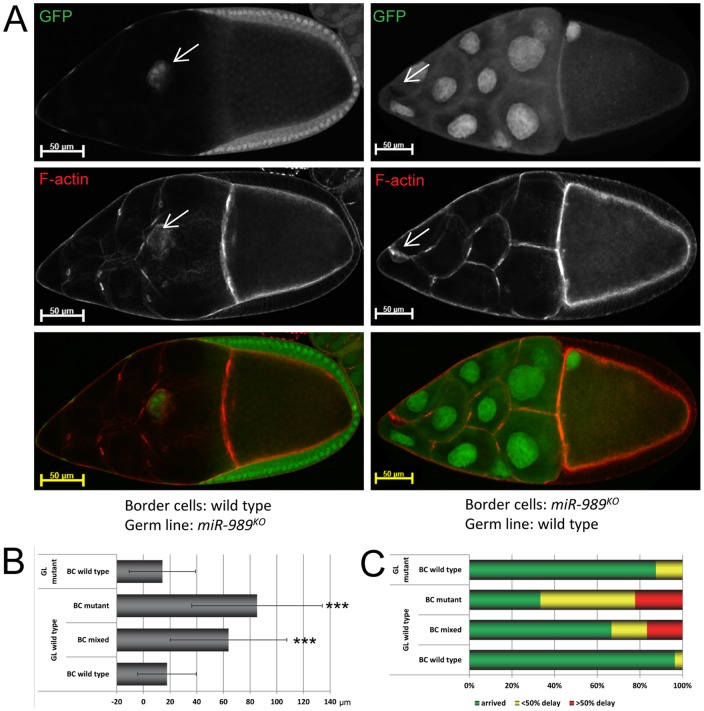
Clonal analysis demonstrates a somatic requirement for miR-989 for normal border cell migration.A Genetic mosaics: wild type cells are labelled by nuclear GFP (upper panel) while miR-989 mutant cells do not express GFP. The middle panels are labelled with phalloidin to highlight the F-actin cytoskeleton. The two egg chambers shown represent extreme cases of mosaicism. In the stage 10A egg chamber on the left all somatic cells are wild-type (GFP positive), while all germ line cells are mutant for miR-989 (GFP negative). The border cells were not delayed in their migration. In the stage 10A egg chamber shown on the right all germ line cells are wild type (GFP positive) while all somatic cells are mutant for miR-989 (GFP negative). Border cell migration was strongly delayed. B Quantification of the migration defects in migrating border cells in late stage 9 and stage 10A egg chambers. GL denotes germ line, and BC border cells. Migration was strongly delayed if the border cells were mutant, but not if the germ line cells lacked miR-989. We observed a population of border cell clusters that were partially wild-type and partially mutant for miR-989. In these cases, border cell migration was also delayed in comparison to controls. *** indicates p<0.001. C Quantification of the migration defects in stage 10B egg chambers. Wild type border cells migrated normally when the germ line was mutant for miR-989. Conversely, miR-989 mutant border cells were delayed when the germ line was wild type.